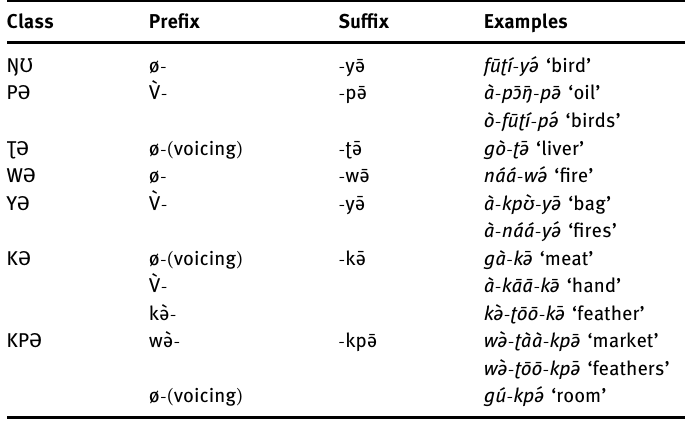
Table 1: Akebu noun classes: markers and